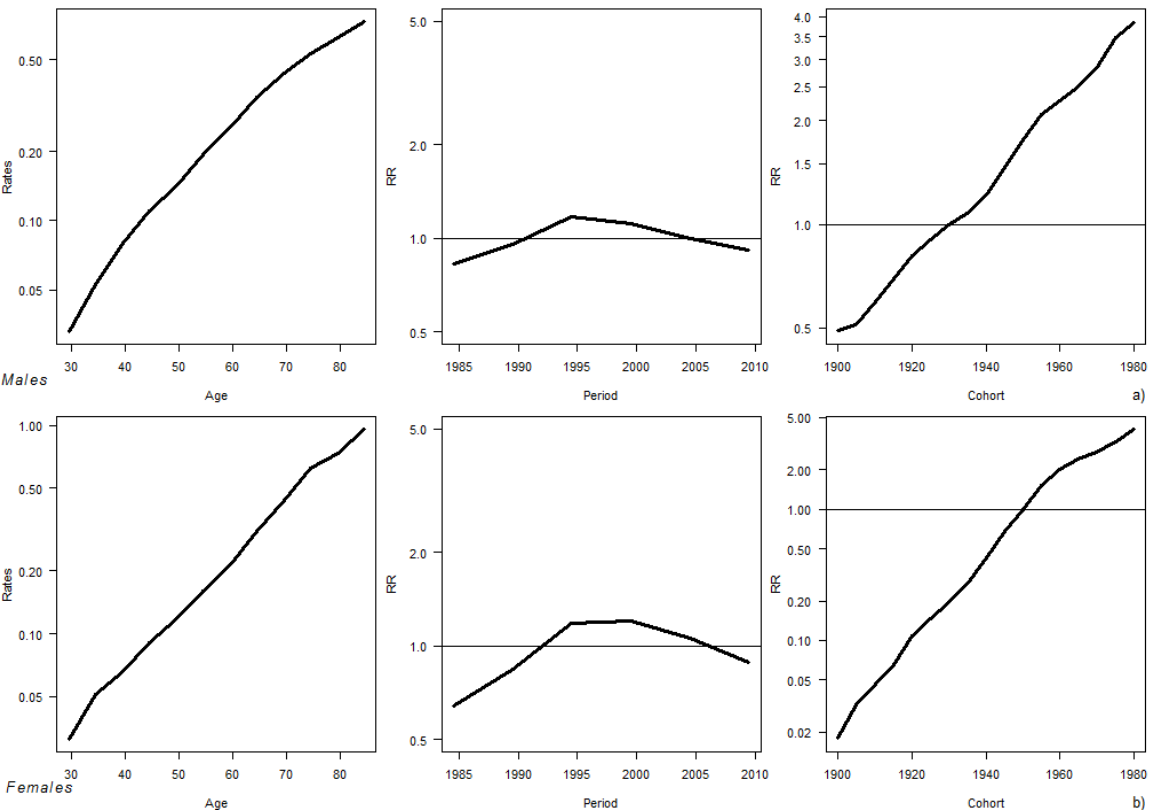
Figure 2. Age, period, and cohort effects from the APC model over the period 1980–2009 for ( a ) males and ( b )